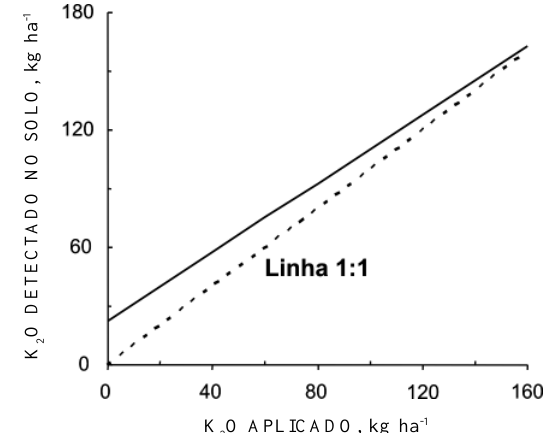
K O APLICADO, kg ha 2 Figura 2. Quantidades de K O detectado no solo, 2 considerando a contribuição do fertilizante aplicado e da palha. A linha cheia corresponde à quantidade adicionada pelo fertilizante mais palha. A linha 1:1 (tracejada) corresponde à adição por meio do fertilizante.